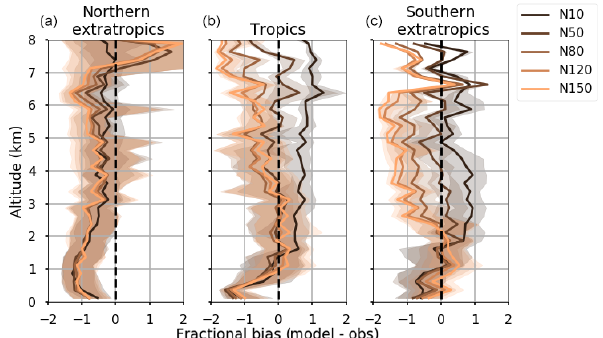
Figure 6. The vertical profile of fractional bias in modelled aerosol number at different size cut-offs for measurements in the northern extratropics (a) , the tropics (b) and the southern extratropics (c) .